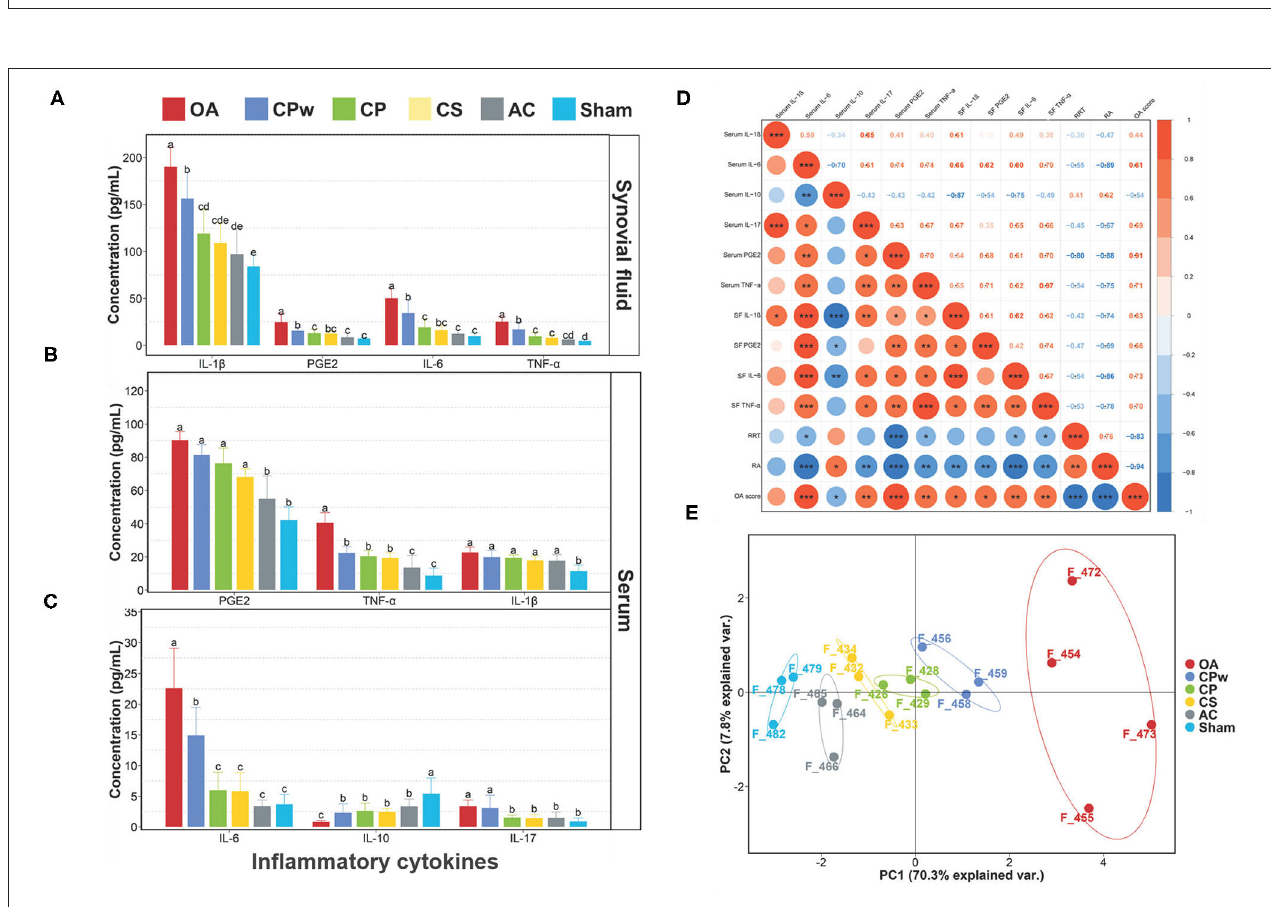
FIGURE 4 | (A) IL-1 β , PGE 2 , IL-6, and TNF- α levels of synovial fluid. (B) PGE 2 , TNF- α , and IL-1 β levels of serum. (C) IL-6, IL-10, and IL-17 levels of serum. (D) Spearman’s r correlations between the inflammatory cytokines and athletic ability. (E) Principal component analysis for different groups. Data were represented as mean ± SD. Duncan’s test was used to evaluate the significant differences between different groups. The different letters mean the significant difference between the two groups. Significant correlations were noted by * P ≤ 0.05, ** P ≤ 0.01 and *** P ≤ 0.001.